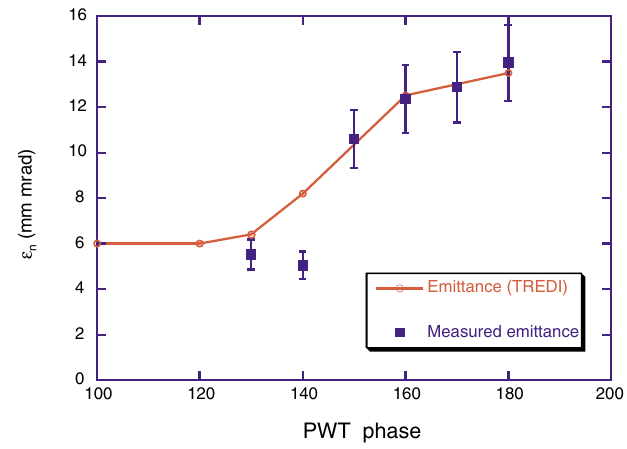
FIG. 14. (Color) Emittance growth during compression, experi- mental results from quadrupole scan, and TREDI multiparticle simulations of compression and measurement